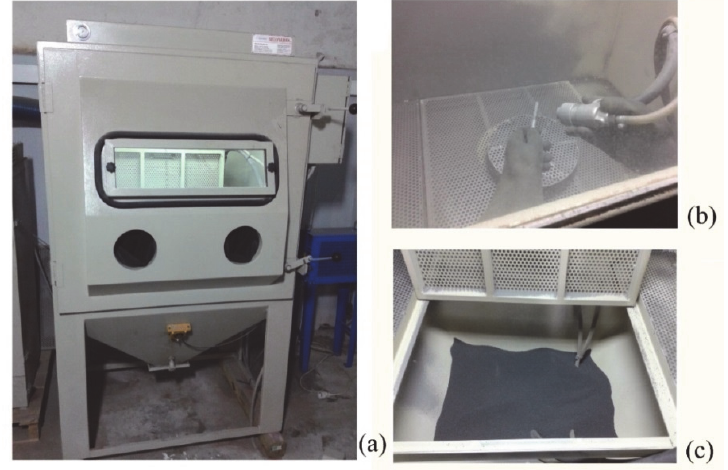
Figure 4: Sandblasting cabinet (a), process (b) and material